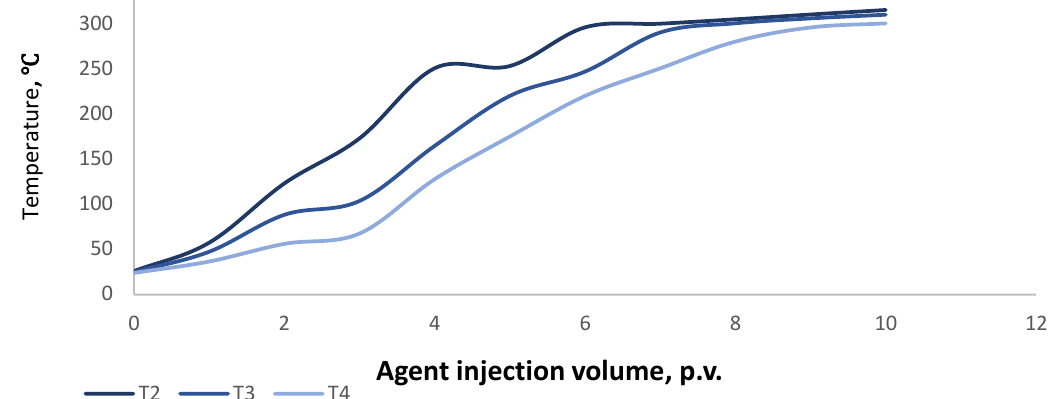
Figure 8. Temperature profiles in the experiment with steam and solvent supplied in a mixed